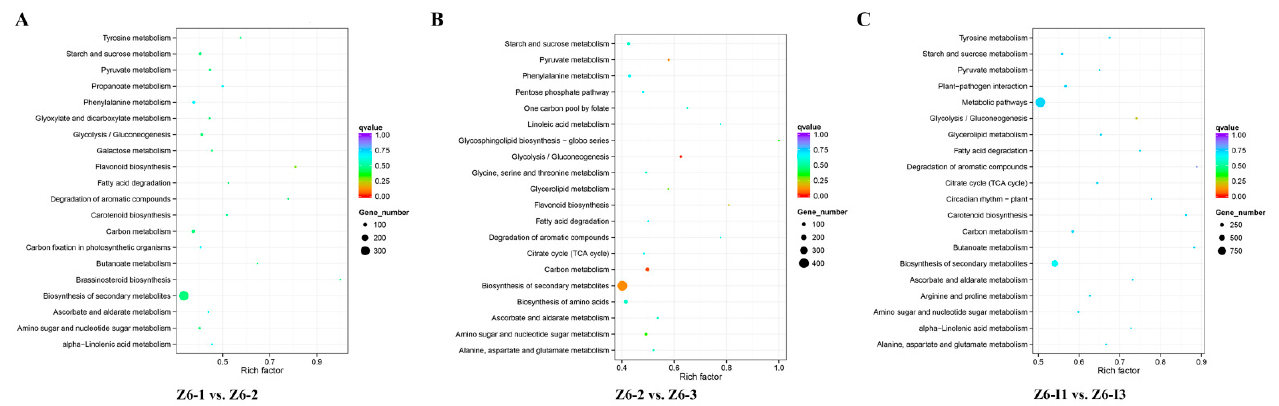
Figure 4. KEGG pathway enrichment analysis of DEGs on pairwise comparisons. ( A ) Comparison of Z6-1 vs. Z6-2. ( B ) Comparison of Z6-2 vs. Z6-3. ( C ) Comparison of Z6-1 vs. Z6-3.